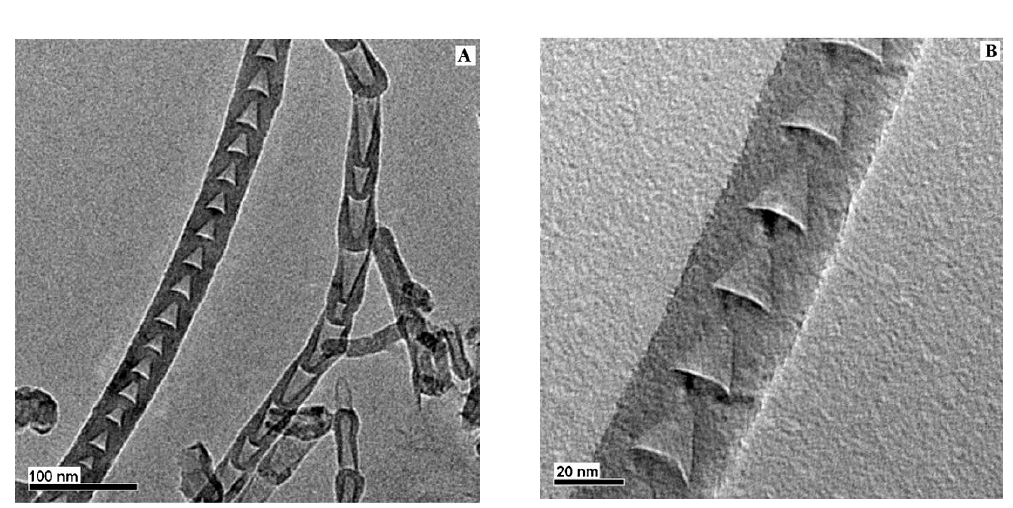
Figure 4. Bamboo-like carbon nanotubes (CNTs) obtained by methane thermal decomposition with Figure 4. Bamboo ‐ like carbon nanotubes (CNTs) obtained by methane thermal decomposition with different catalysts ( A ) Ni-Tween 20 and ( B ) Ni-NaBH 4 nanoparticles (reprinted with permission from different catalysts ( A ) Ni ‐ Tween 20 and ( B ) Ni ‐ NaBH 4 nanoparticles (reprinted with permission from Ref. [57], copyright 2011 Ref. [57], copyright 2011 Elsevier).